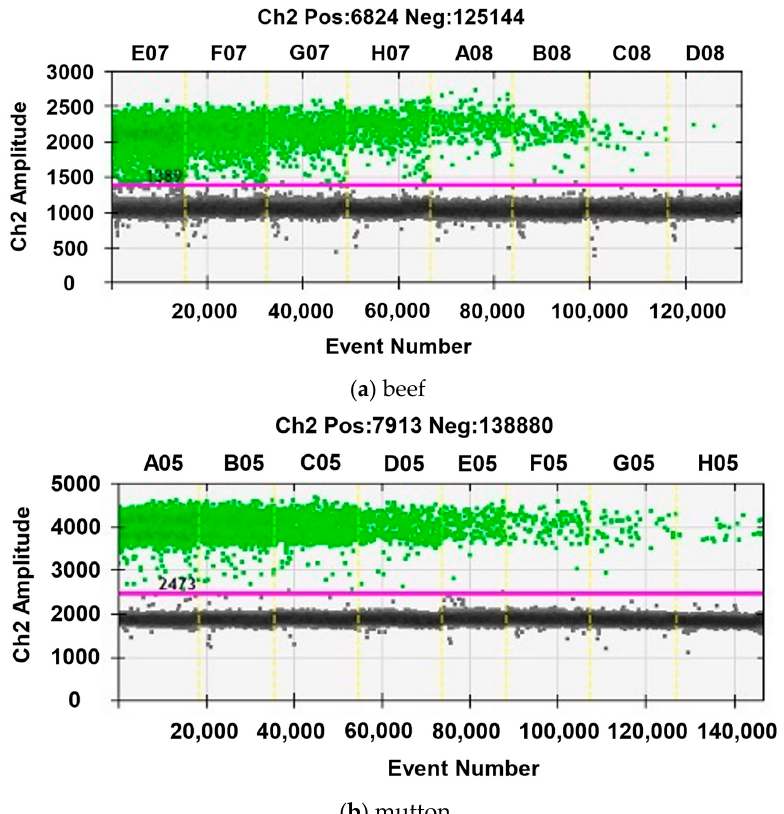
Figure 1 . Scatterplot under different template concentrations, ( a ) beef, ( b ) mutton. Each droplet is plotted on the graph of fluorescence intensity versus droplet number. The eight columns represent serial dilution of each meat DNA. The amplitude graph shows positive (in green) and negative (in black) droplet populations. The threshold is set in between, as indicated by the purple line.